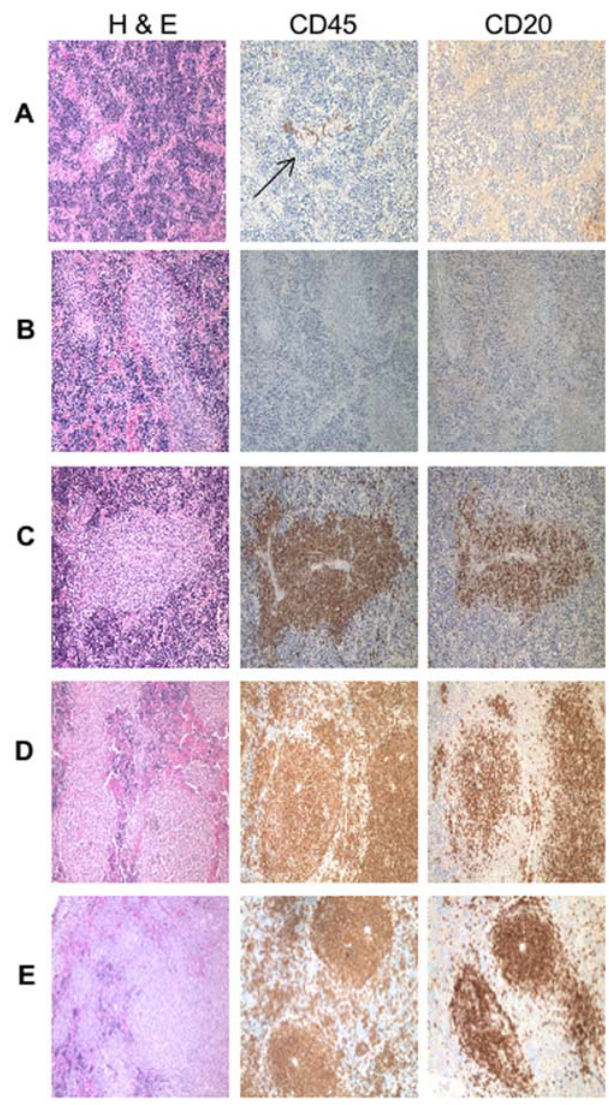
Figure 5. Immunohistology. Higher magnification images (100 6 ) of portions of the sections shown in figure 3. Estimates of percentages of B cell engraftment are done at this magnification by comparing the percentage of the splenic section staining with